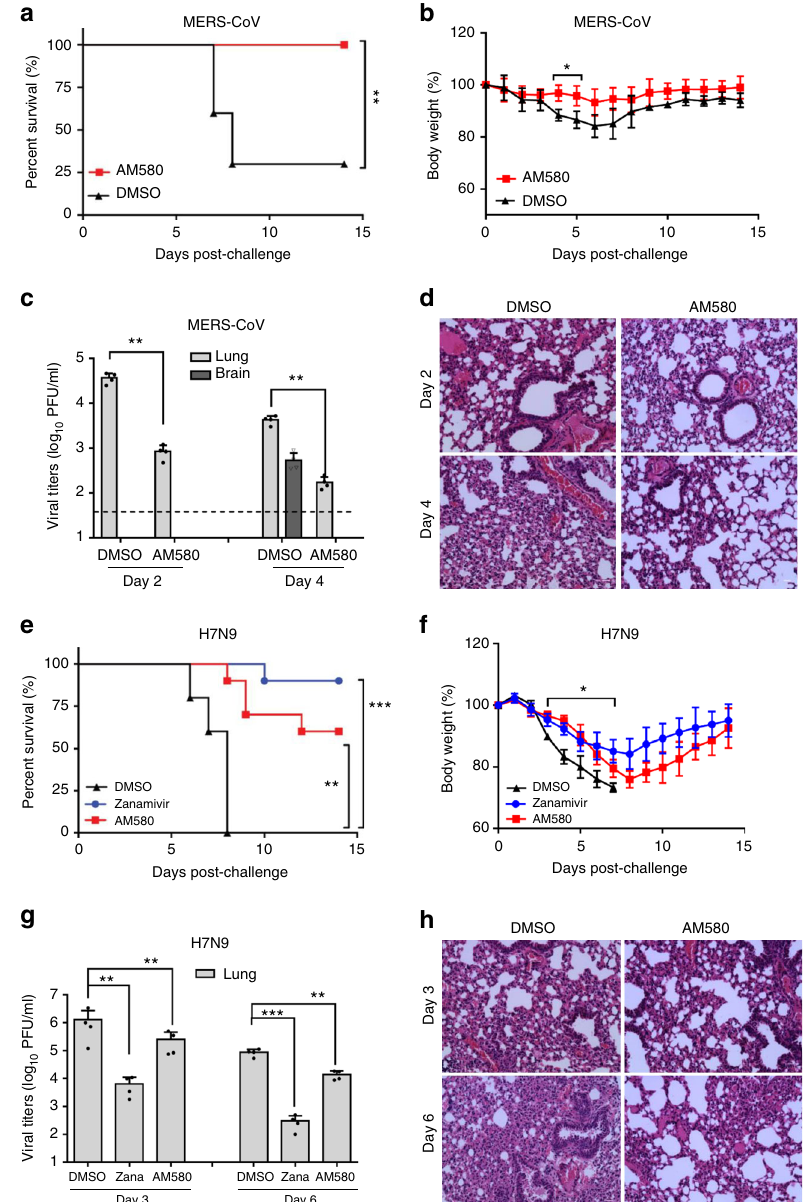
Fig. 3 In vivo antiviral activity of AM580. a DDP4 transgenic mice were treated by intraperitoneal inoculation of AM580 (red square) or 0.1% DMSO (placebo control, black triangle) for 3 days starting 6 h post-challenge with 50PFU of MERS-CoV. Survivals and clinical disease were monitored for 14 days or until death. Differences in survival rates between groups were compared using Log-rank (Mantel – Cox) tests. b Daily body weights of surviving mice. Student ’ s t -test was used to compare different groups on each day post-infection. c Lung and brain tissues were collected for detection of viral yields using both plaque assay and RT-qPCR assays (Supplementary Figure 7). Difference were compared with DMSO-treated groups using Student ’ s t -test. d Representative histologic sections of lung tissues from the indicated groups with hematoxylin and eosin (H&E) staining. Greater alveolar damage and interstitial in fl ammatory in fi ltration were present in the DMSO group. e – h Balb/c mice were treated with intranasal AM580 (red square), zanamivir (positive control, blue dots), or 0.1% DMSO (negative control, black triangle) for 3 days starting 6 h post-challenge with 100 PFU of in fl uenza A (H7N9) virus. Shown are survival rate ( e ), mean body weight ( f ), lung viral load ( g ), and representative lung sections stained by H&E ( h ). The same statistical analyses were performed as described in a – d . Results are presented as mean values ± s.d. *** p < 0.001,** p < 0.01, * p < 0.05. Scale bar: 20 µ